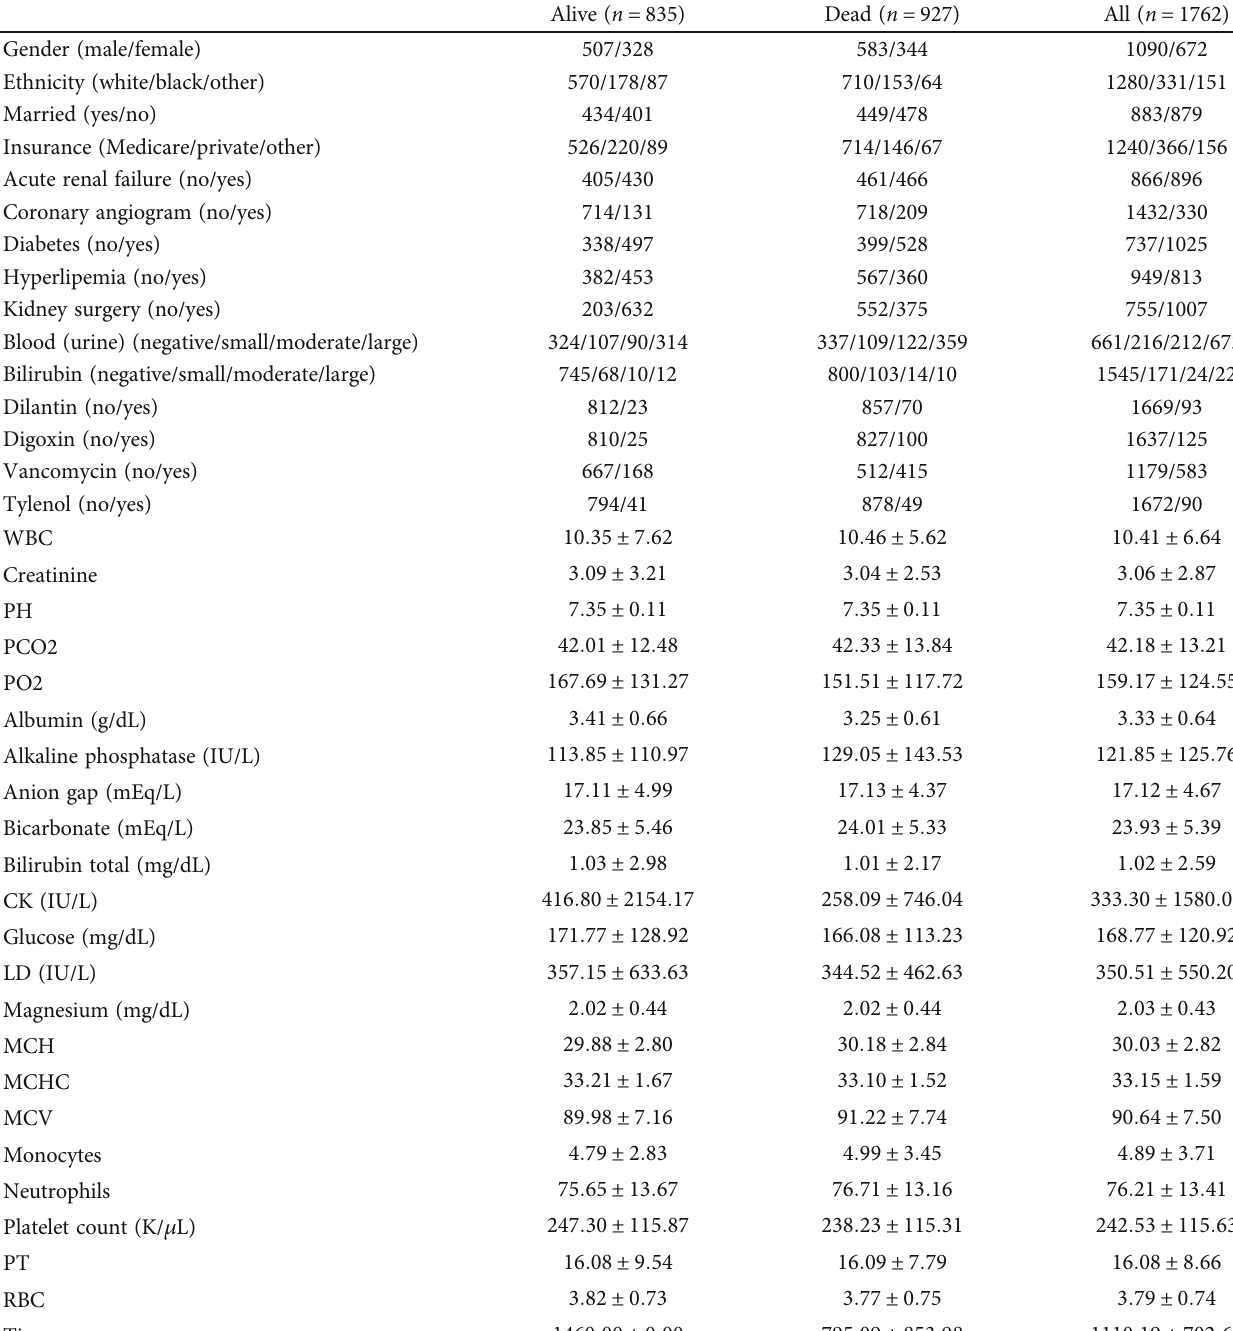
Table 1: A description of all the